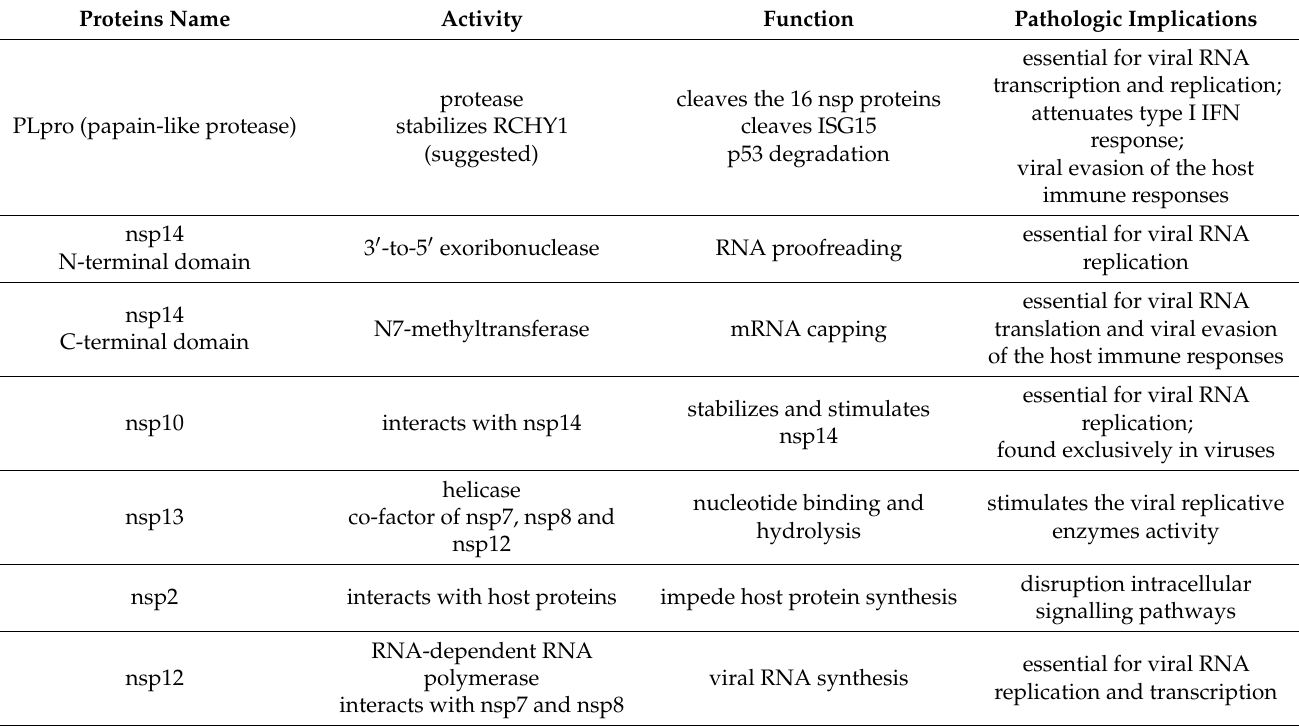
Table 2. SARS-CoV-2 zinc finger proteins in COVID-19 viral